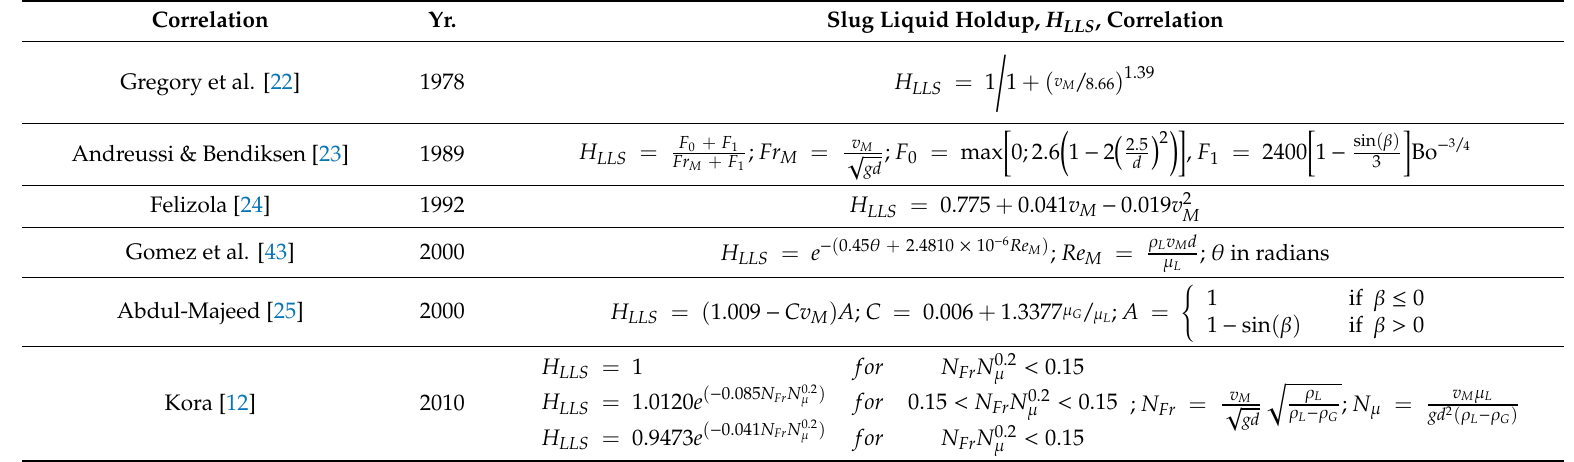
Table 4. Summary of slug liquid holdup, H LLS ,